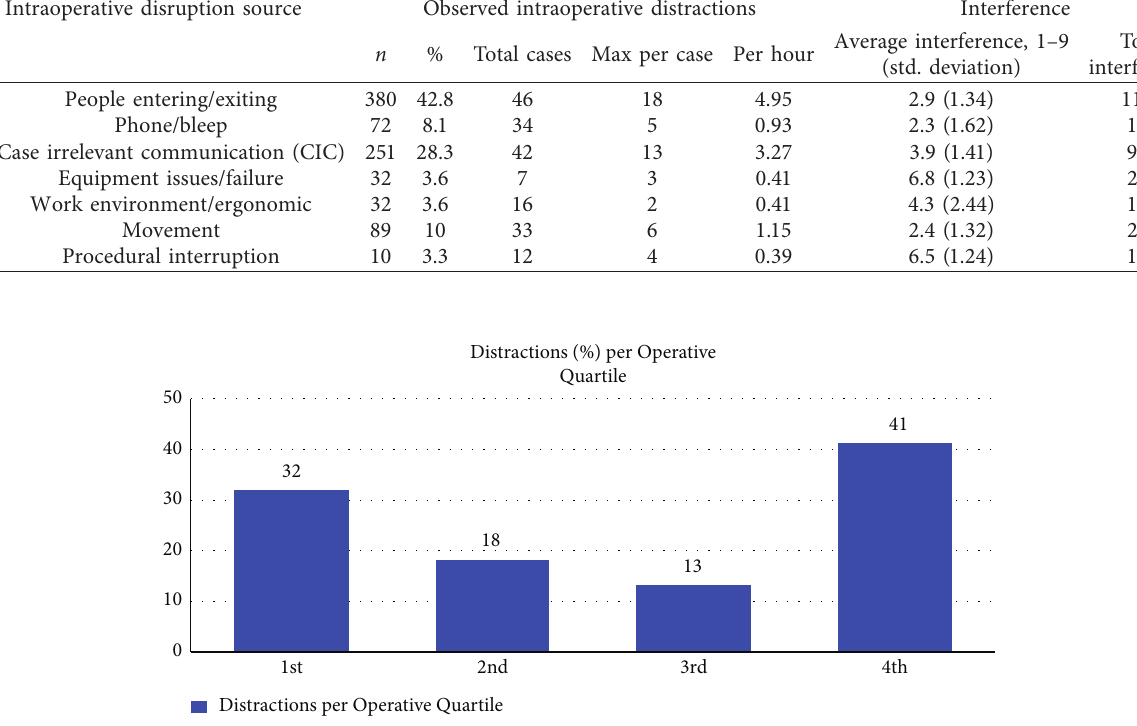
Figure 1: Timed distractions during the course of 46 surgical procedures divided into quartiles ( n � % of total distractions observed).